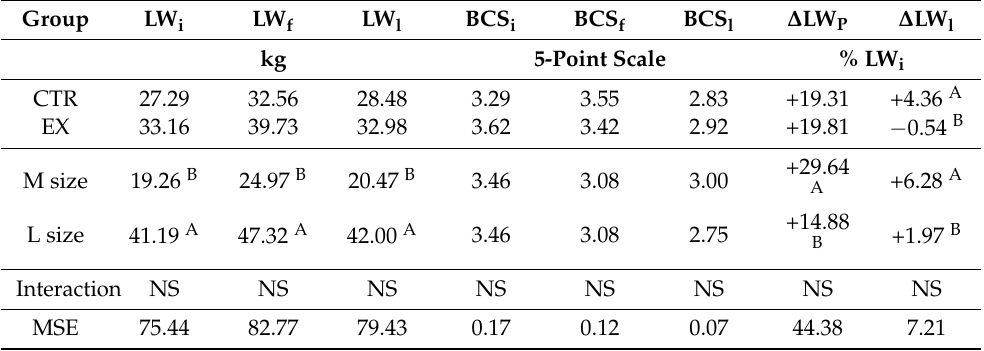
Table 3. Trend of bitches’ body weight (LW) and body condition score (BCS) during pregnancy and lactation.